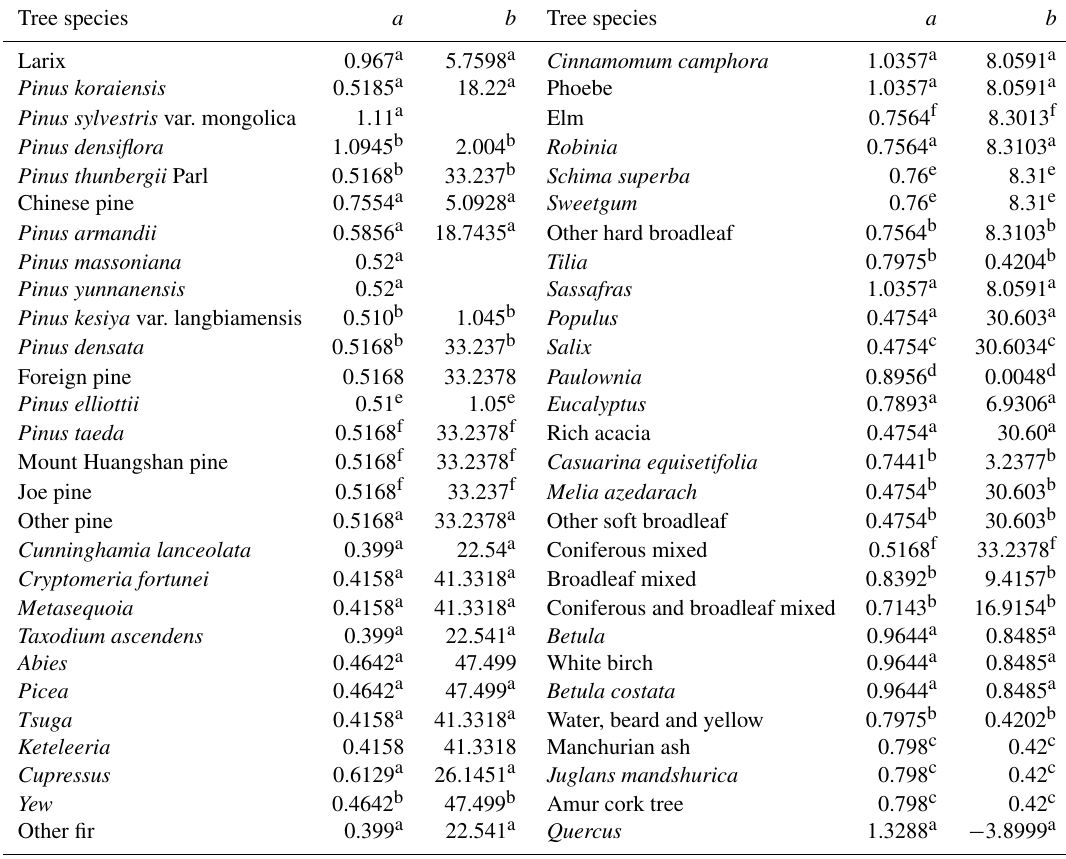
Table 2. Parameters of the linear regression model for biomass and stock volume of dominant tree species. Tree species